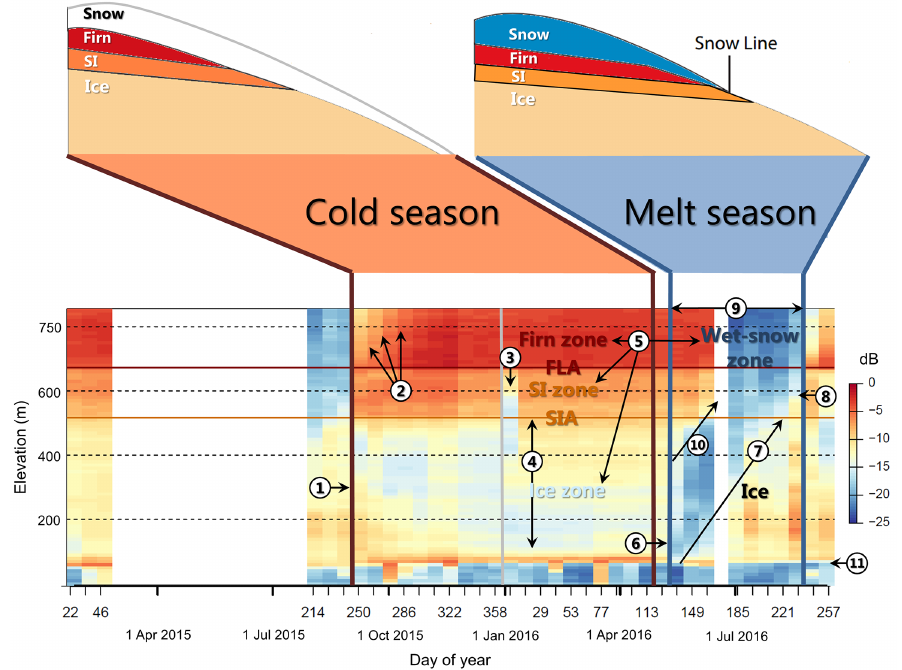
Figure 2. A heat plot of Sentinel-1A backscatter (dB) time series from 22 January 2015 to 13 September 2016 (DOY 22 2015 to 257 2016), along a profile on Kongsvegen, Svalbard. It is 12 days between each Sentinel-1 acquisition. The numbers represent 11 possible glacier mapping variables that can be detected from the SAR time series: (1) onset of cold season; (2) freeze-up and evolution of the firn area as the winter cold wave penetrates the snow and firn; (3) winter rain event; (4) change of surface properties after winter rain event; (5) glacier facies, separated by firn line altitude (FLA) and superimposed ice altitude (SIA) (SI is superimposed ice); (6) onset of melt season; (7) transient snow lines (TSL); (8) end of summer snow line (EOSS); an estimation of the equilibrium line altitude (ELA); (9) length of melt season; (10) surface dry-to-wet snow line; and (11) glacier outline or calving front. The two sketches above the heat plot represent the SAR glacier zones in the cold season (winter with dry and cold conditions; snowpack is transparent due to high volume scattering) and in the melt season (summer with warm and wet conditions), together representing a full mass balance year. (Illustration insets above the heat plot are modified based on de Ruyter de Wildt et al.,